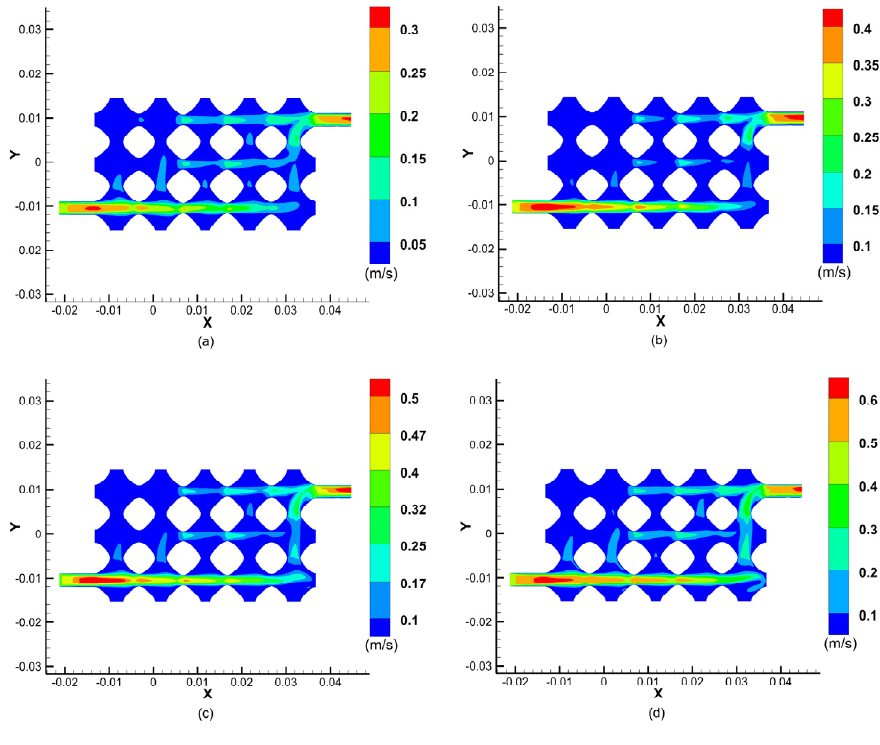
Figure 6. Simulation results of the fluid velocity at different perfusion pressures: ( a ) 12 mmHg; ( b ) 13 mmHg; ( c ) 14 mmHg; ( d ) 15 mmHg.